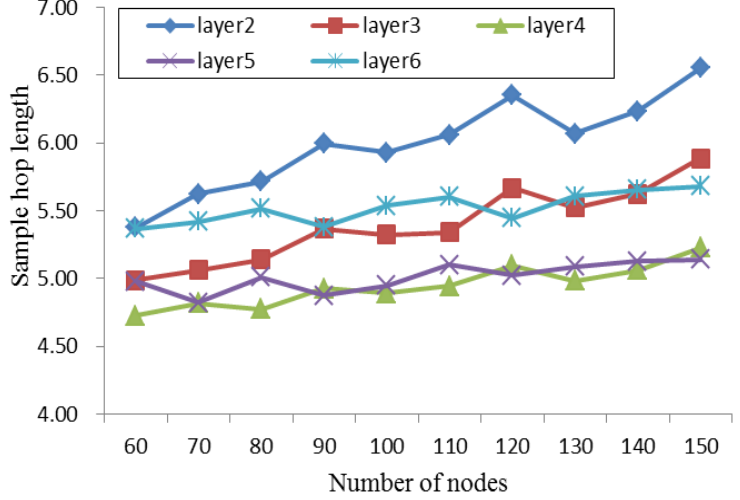
Figure 2. Average path length in a scatternet.